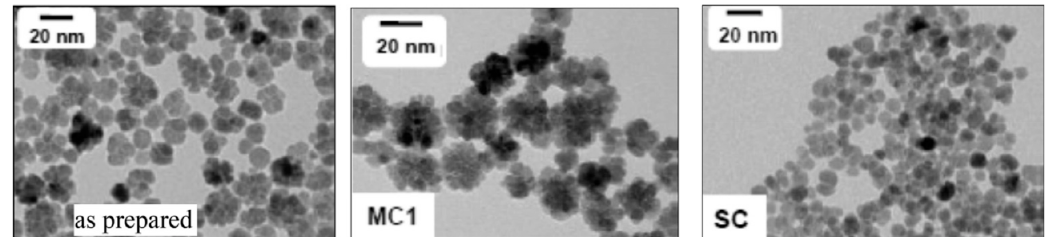
Figure 2. TEM images of the polydisperse mixture of iron oxide nanoparticles (IONPs) (as prepared left side) and its fractions containing multicore (MC1 middle) and single core (SC right side) nanoparticles. Reprinted with permission from Reference [84].